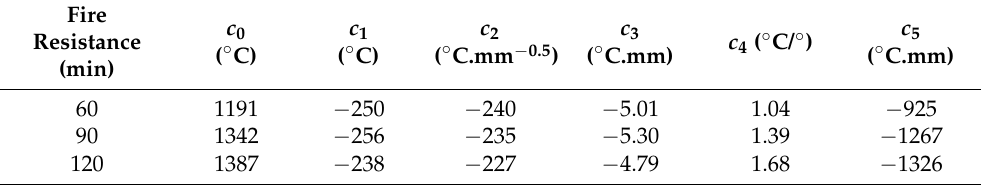
Figure 1. Definition of the geometry factors for the composite slab: l 1 , l 2 , l 3 , h 1 and h 2 (mm) are structure geometry parameters; A (mm 3 /m) is the concrete volume of the rib per meter of rib length; Lr (mm 2 /m) is the exposed area of the rib per meter of rib length; u 1 and u 2 (mm) are defined by the shortest distance of the centre of the rebar to any point of the webs of the steel deck; u 3 (mm) is the distance to the lower flange and α ( ◦ ) is the angle of the web. Table 2. Coefficients for the determination of the temperature in rebars